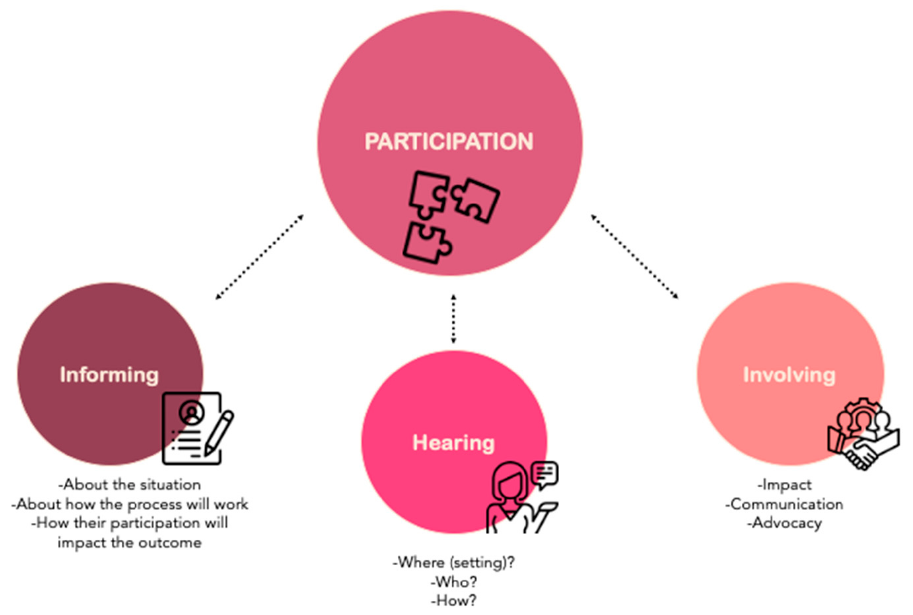
Figure 1. Participation and its three dimensions .